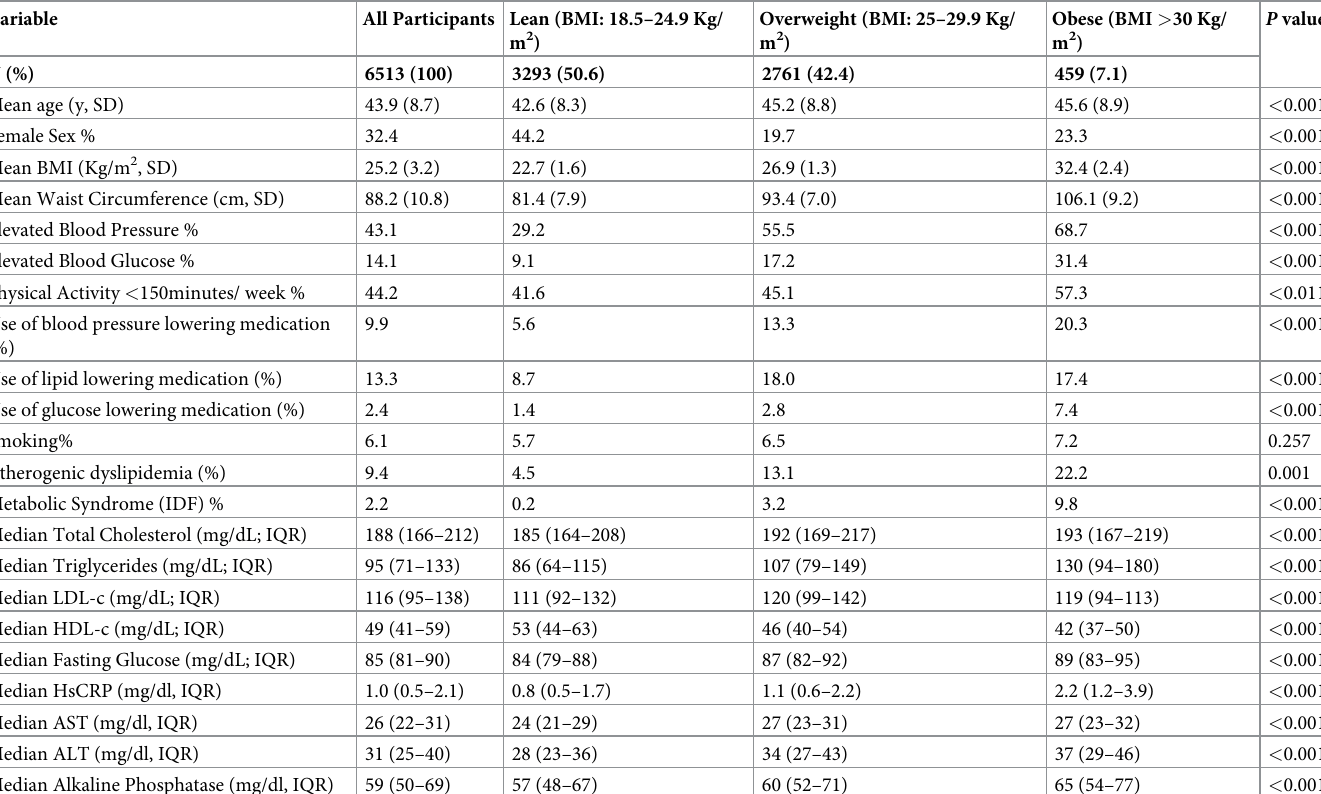
Table 1. Characteristics of participants at baseline according to BMI